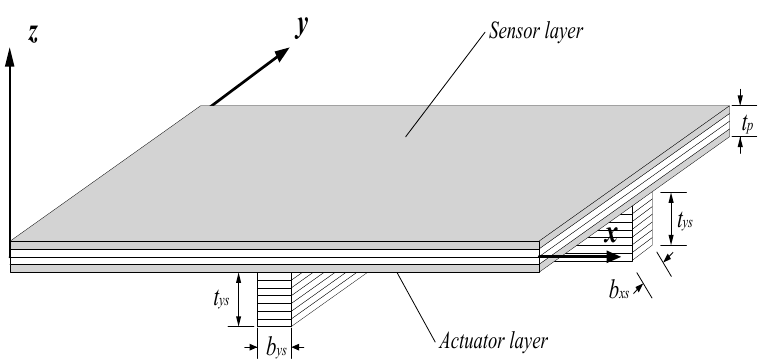
Figure 1. Sti ff ened model with piezoelectric sensors and